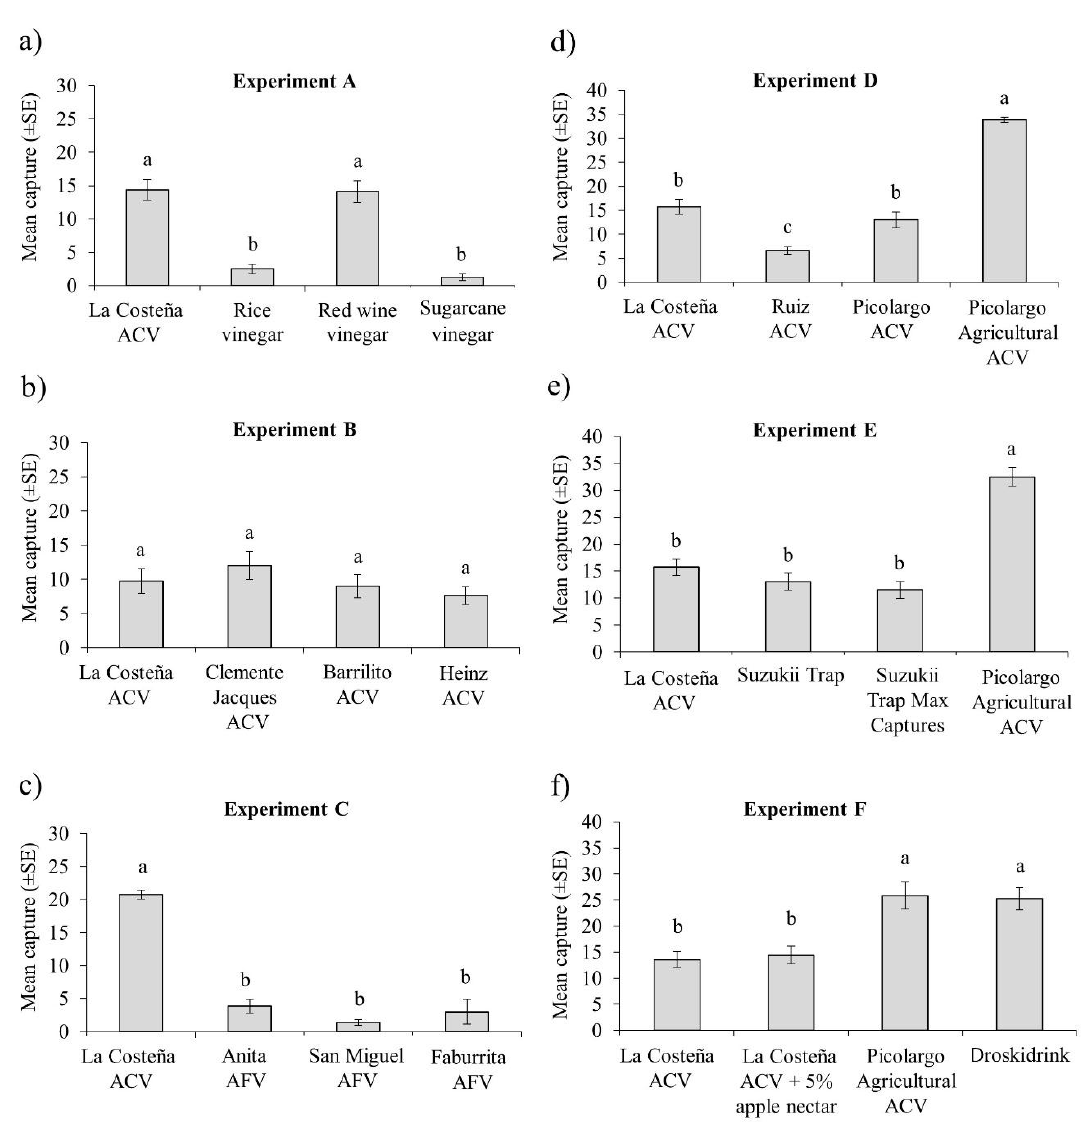
Figure 1. Mean number of D. suzukii flies captured per trap in laboratory cage Experiments (A–F) with ( a ) La Costeña apple cider vinegar (ACV) and other types of vinegars, ( b ) di ff erent brands of ACV, ( c ) di ff erent brands of apple flavored vinegar (AFV), ( d ) di ff erent brands of ACV including an agricultural-grade ACV unfit for human consumption, ( e ) comparison of agricultural-grade ACV with two commercial attractants, ( f ) comparison of agricultural-grade ACV and ACV + 5% apple nectar with Droskidrink (ACV, red wine and sugar). La Costeña ACV was included as a reference treatment in all experiments. Vertical bars indicate SE. Columns headed by di ff erent letters di ff er significantly (ANOVA, Tukey p < 0.05).